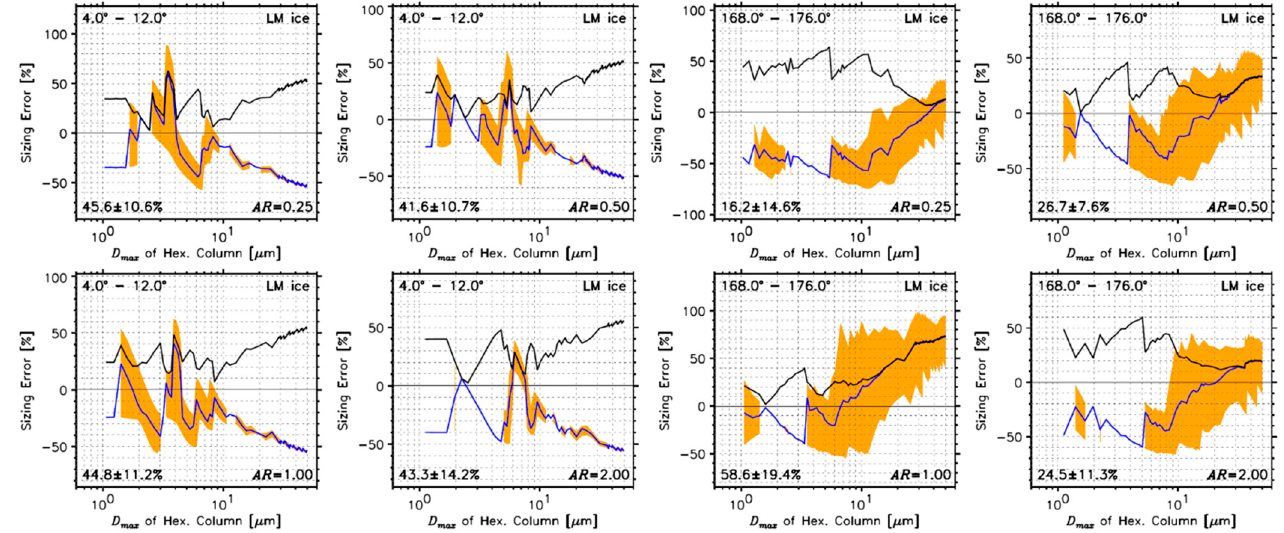
Figure 9. The same as Figure 8, but spherical ice cloud droplets were assumed for the Lorenz–Mie calculations (LM ice).